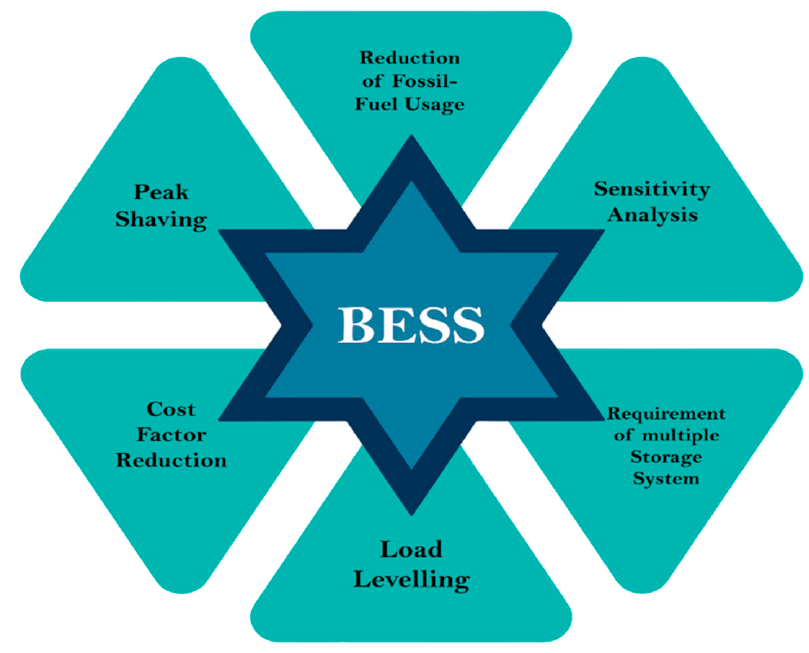
Figure 5. Advantages rendered by BESS integration on DN. Mediation maintains ESS when energy is low-cost. It balances the load during peak demand when electricity rates rise [34]. Thus, the load is distributed at a low cost through- out the service’s lifetime. As shown in Figure 6, the practice of relieving load or balancing